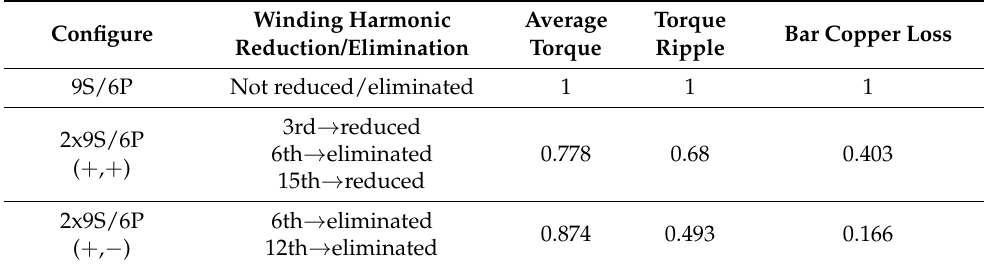
Table 1. Normalized performance characteristic